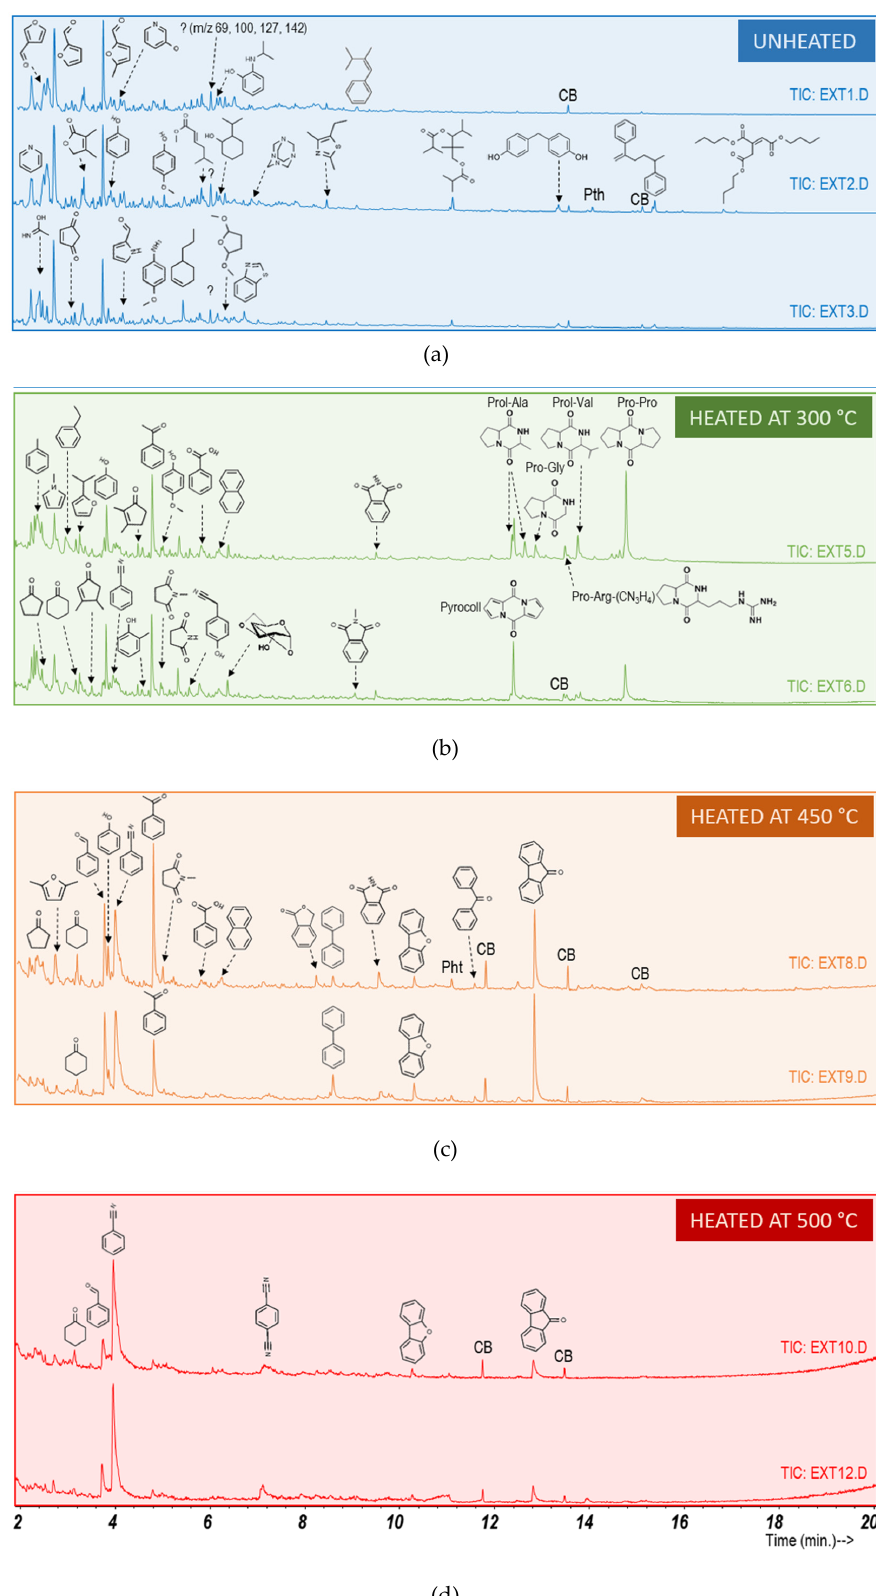
Figure 2. Total-ion current (TIC) chromatogram obtained from GC-MS analysis of the soil:water extract used to prepare different culture medias. (a) Unheated-control; (b) heated at 300 ° C; (c) heated at 450 ° C and (d) heated at 500 ° C. The main identified compounds have been represented.